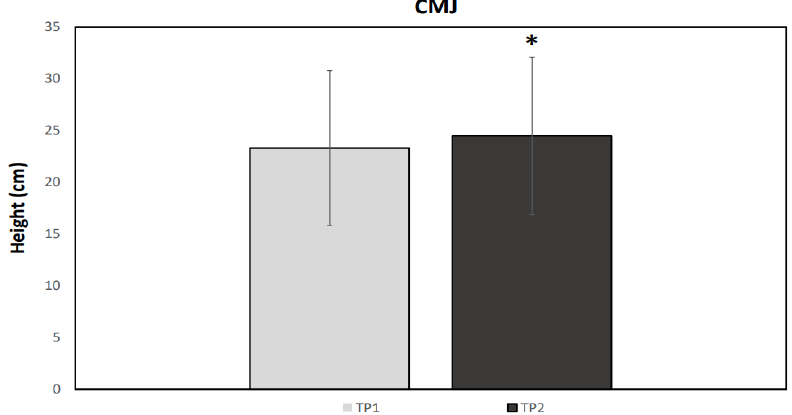
Figure 4. Mean values for the 20-m linear sprint performance during the two testing points (TP1 and TP2). * Statistically significant difference ( p < 0.05).